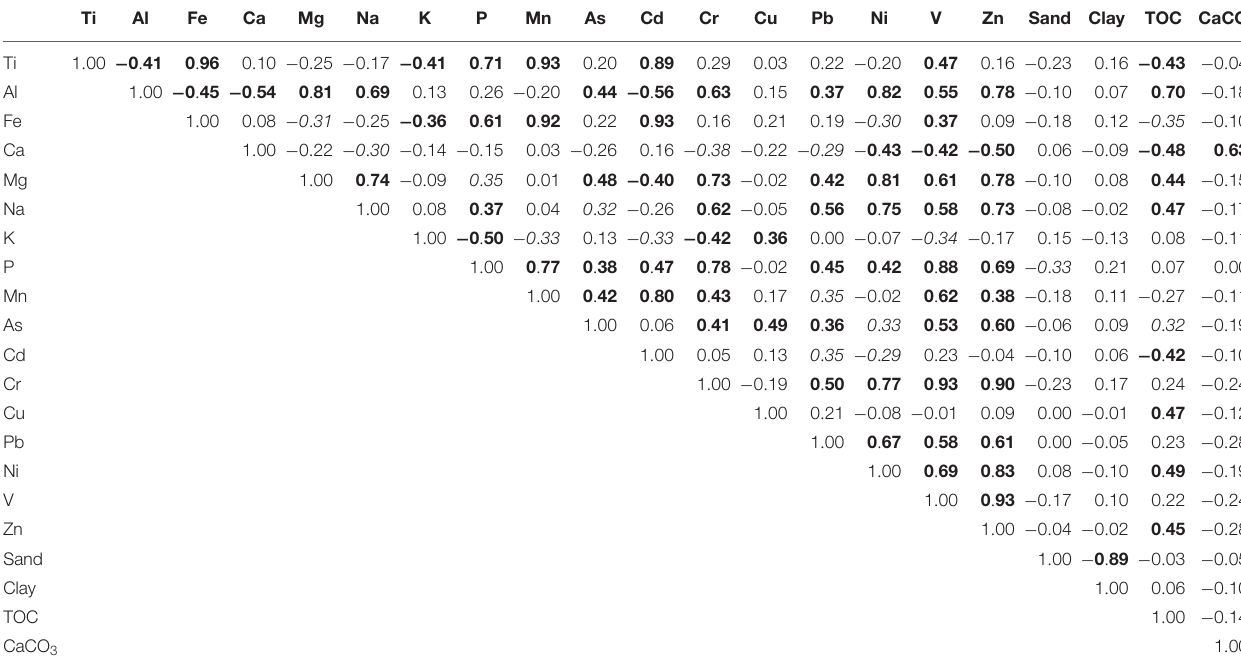
TABLE 3 | Correlation coefficients (r) between different pairs of sedimentological and geochemical variables ( N = 50). Ti Al Fe Ca Mg Na P Mn As